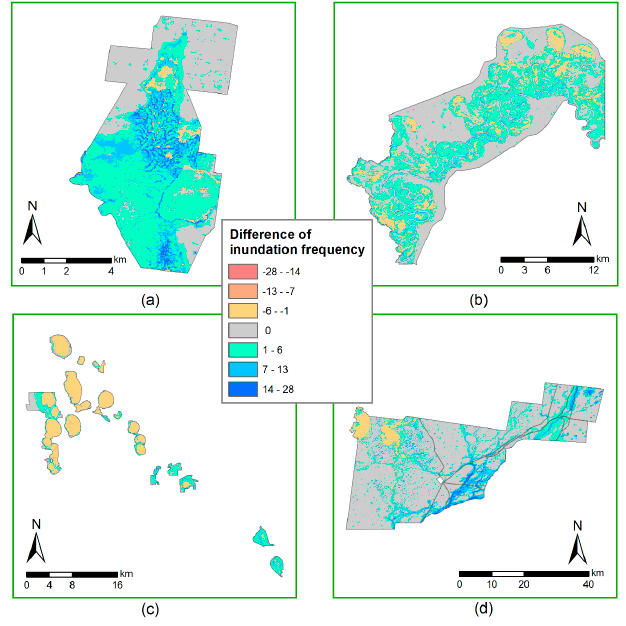
Figure 10. Differences of inundation frequency in the 28 years detected by WOfS and GSWD at ( a ) Narran Lake Nature Reserve, ( b ) Riverland, ( c ) Kerang Wetlands ( d ) Currawinya Lakes.